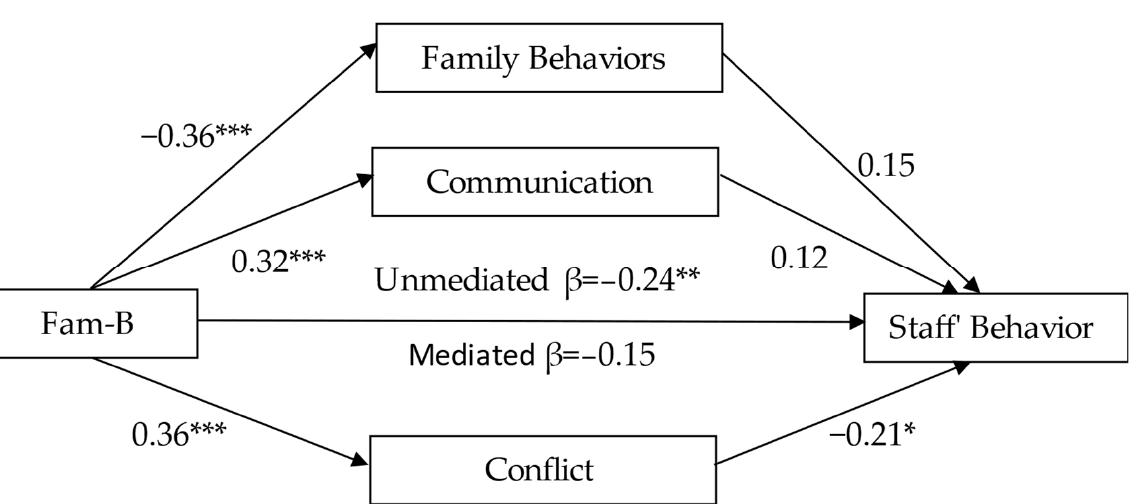
(Family Behaviors, Communication and Conflict). Standardized regression coefficients are provided